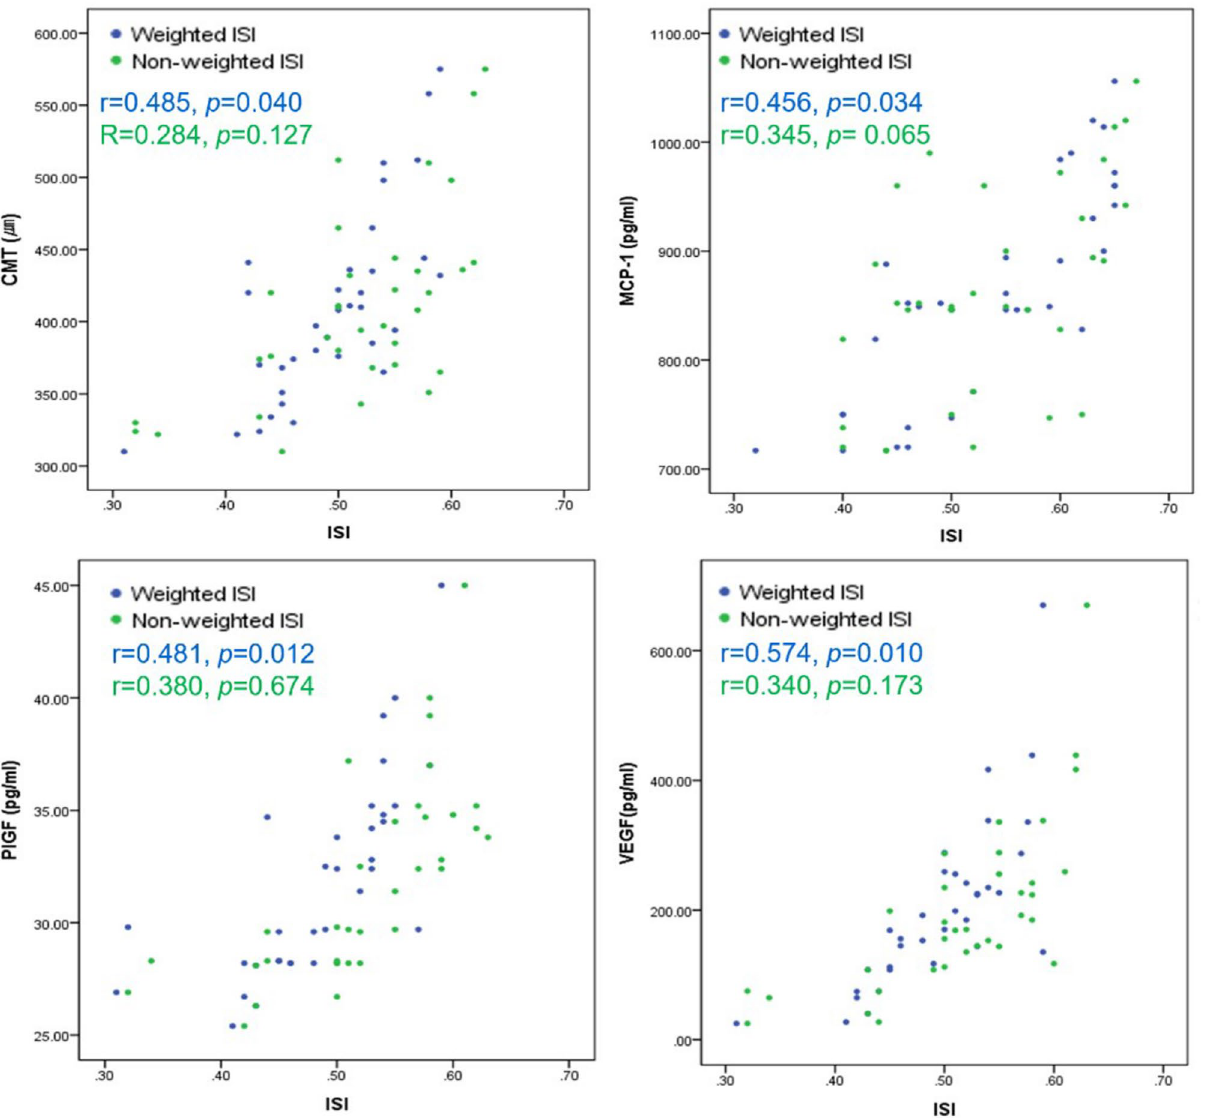
Figure 2. Correlations of the ischemic index (ISI) of NPR with leakage with the central macular thickness (CMT) and aqueous cytokine levels. While the weighted ISI of NPR with leakage had a significant positive correlation with CMT, levels of monocyte chemoattractant protein (MCP)-1, placental growth factor (PlGF), and vascular endothelial growth factor (VEGF)-A, the non-weighted ISI of NPR with leakage showed no significant correlation with